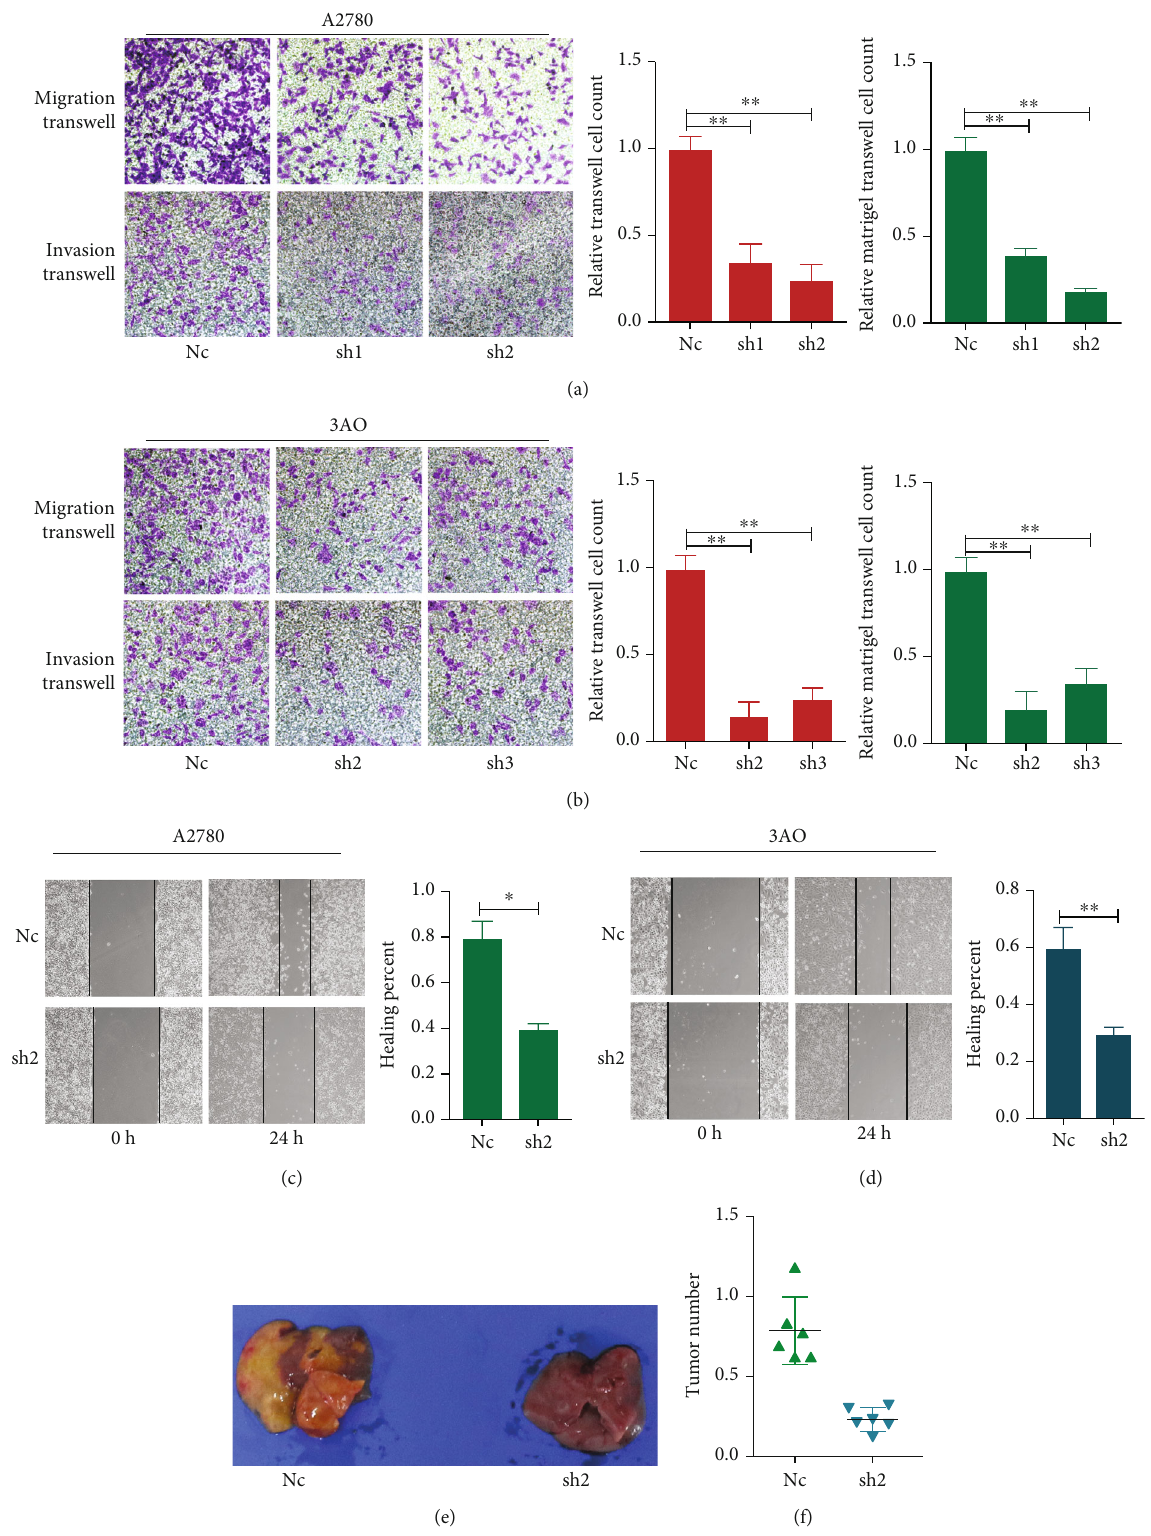
Figure 4: Silencing of WTAP reduces the migration and invasive capacity of OC cells in vitro and metastasis in vivo . (a and b) Representative migration and invasion images of WTAP silenced and Nc cells in A2780 and 3AO. Original magni fi cation: 200x. Calculations of cell number were performed with three randomly selected fi elds. (c and d) Representative wound healing images of A2780 and 3AO at 0 and 24h, respectively, the cell boundary was marked by the dotted black line. ∗ P < 0 : 05 , ∗∗ P < 0 : 01 . (e) Pulmonary metastasis models were established and typical diagram was shown. (f) Statistical analysis of numbers of pulmonary metastatic